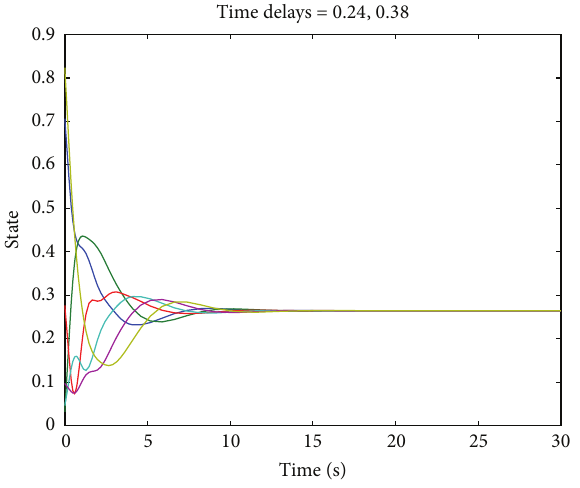
Figure 2: State trajectory of system (1) with G = G 𝑎 . Time delays = 0.22 , 0.26